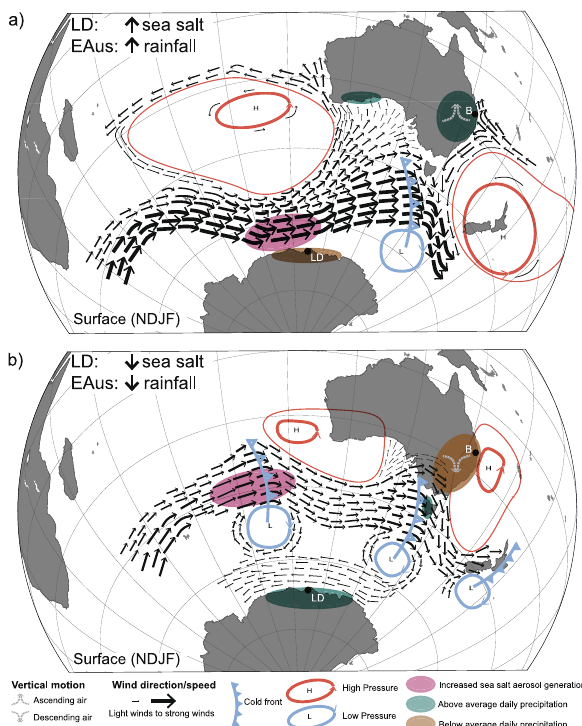
Fig. 6 Schematic of favourable synoptic weather conditions (late austral spring – summer) in the Indo-Paci fi c sector of the Southern Ocean that support the observed teleconnection between Law Dome summer sea- salt (LD sss ) and subtropical eastern Australia rainfall. a Increased LD sss linked to above average rainfall in eastern Australia. b Decreased LD sss linked to below-average rainfall in eastern